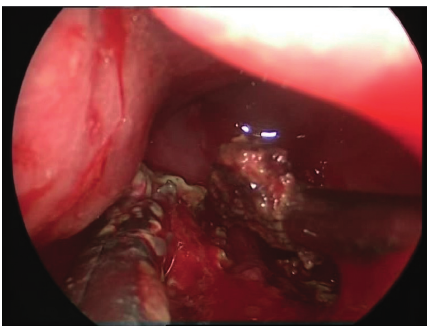
Figure 11: Intraoperative endoscopic view showing the sphenoid is full with fungal debris post endonasal endoscopic pituitary surgery.